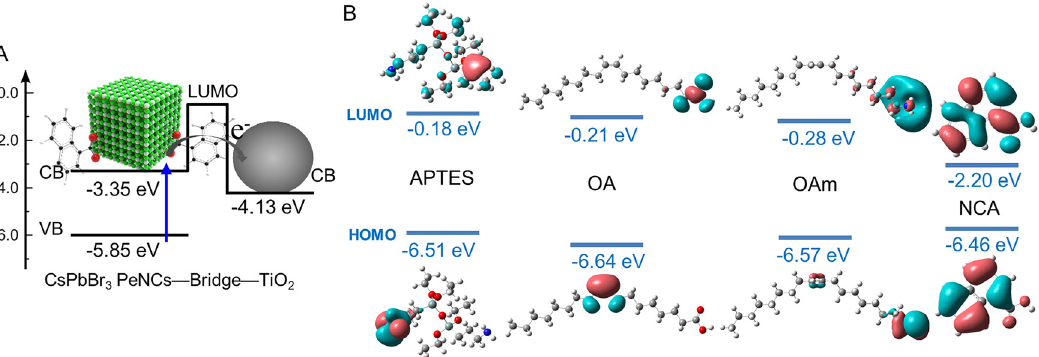
Figure 3: (A) Schematic illustration of the ET process for CsPbBr 3 PeNCs-Bridge-TiO 2 system. (B) Energetic and spatial distribution of frontier orbits of ligand-bridge molecules APTES, OA, OAm and NCA. VB, valance band; CB, conduction band; HOMO, highest occupied molecular orbital; LUMO, lowest unoccupied molecular